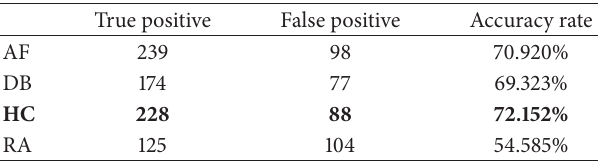
Table 1: Comparison of results between different clustering meth- ods in first evaluation